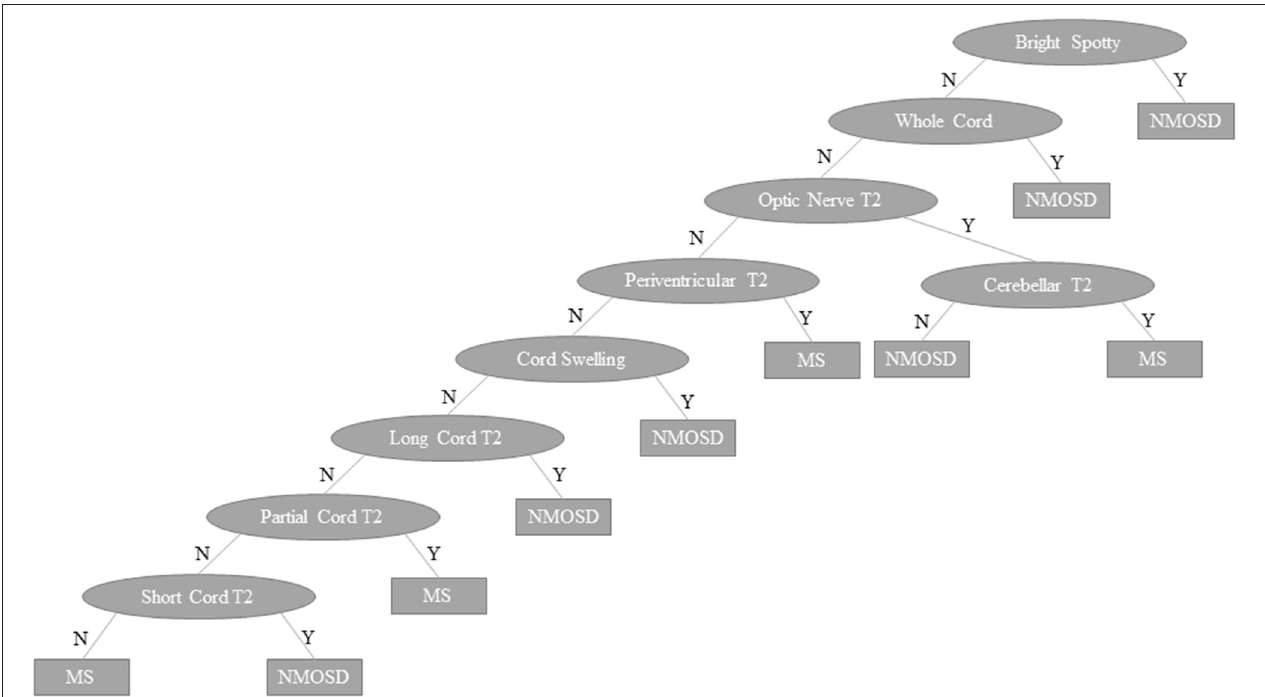
FIGURE 11 | Machine learning decision tree to distinguish NMOSD from multiple sclerosis based binarised presence (Y) or absence (N) of specific lesion types and features as indicated in ovals. NMOSD, neuromyelitis optica spectrum disorder; MS, multiple sclerosis, Y, yes; N,